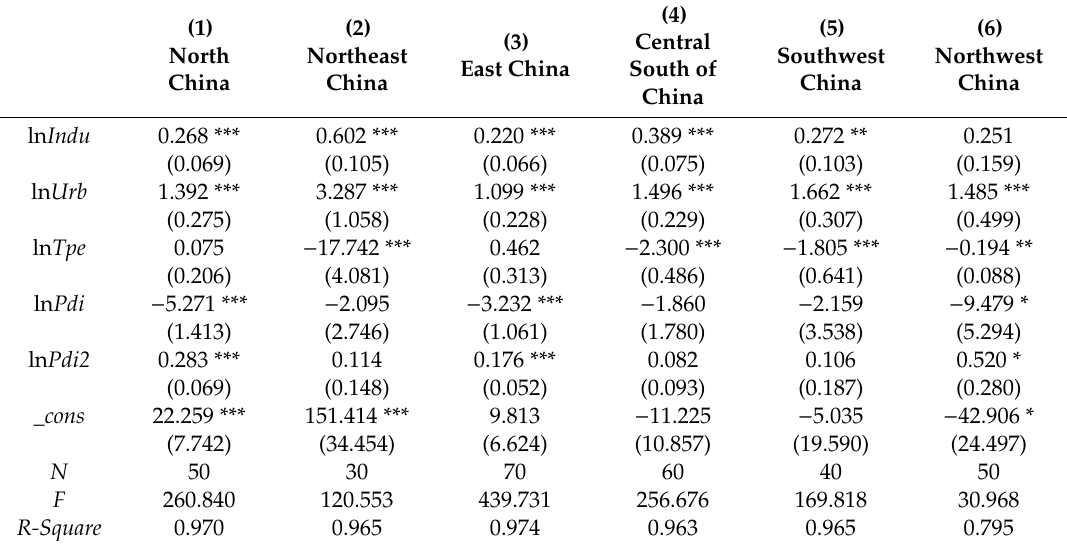
Table 6. Estimation results of samples in di ff erent geographical